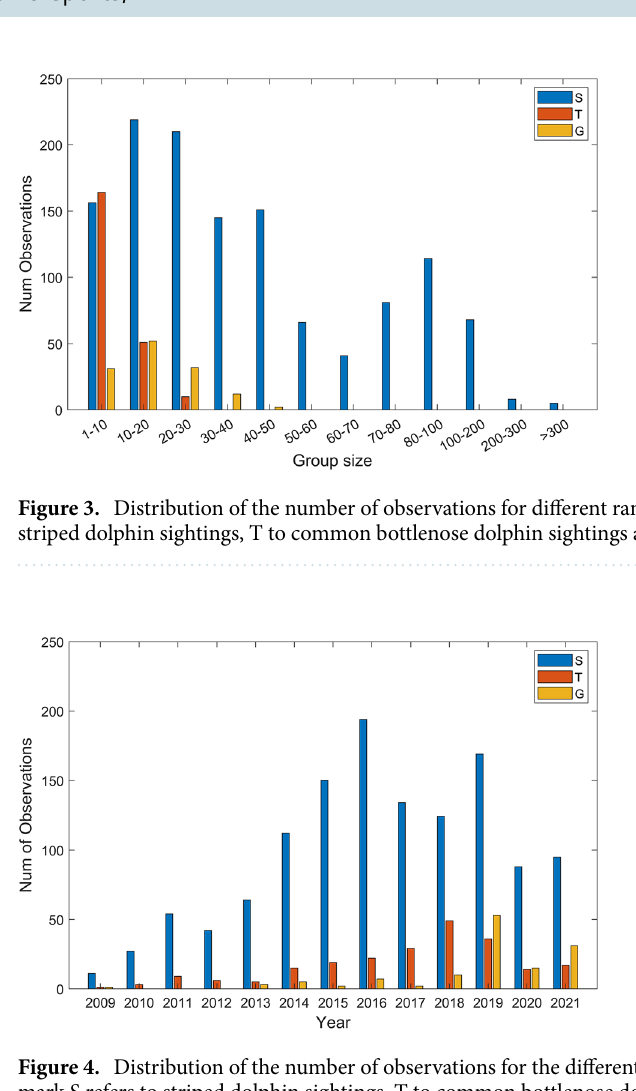
Figure 4. Distribution of the number of observations for the different species in the period 2009–2021: the mark S refers to striped dolphin sightings, T to common bottlenose dolphin sightings and G refers to Risso’s dolphin